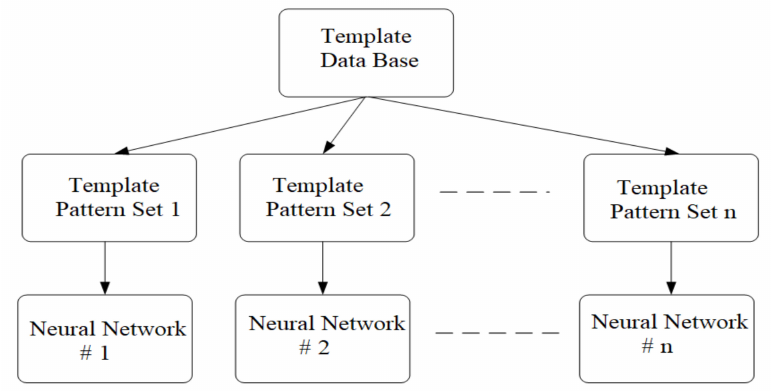
Figure 6. Scheme used to train competing neural networks.